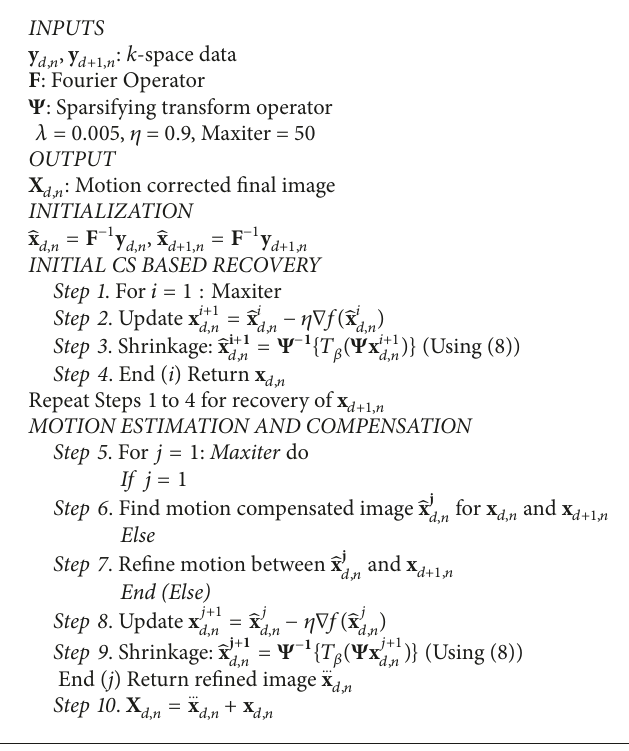
Algorithm 1: The proposed